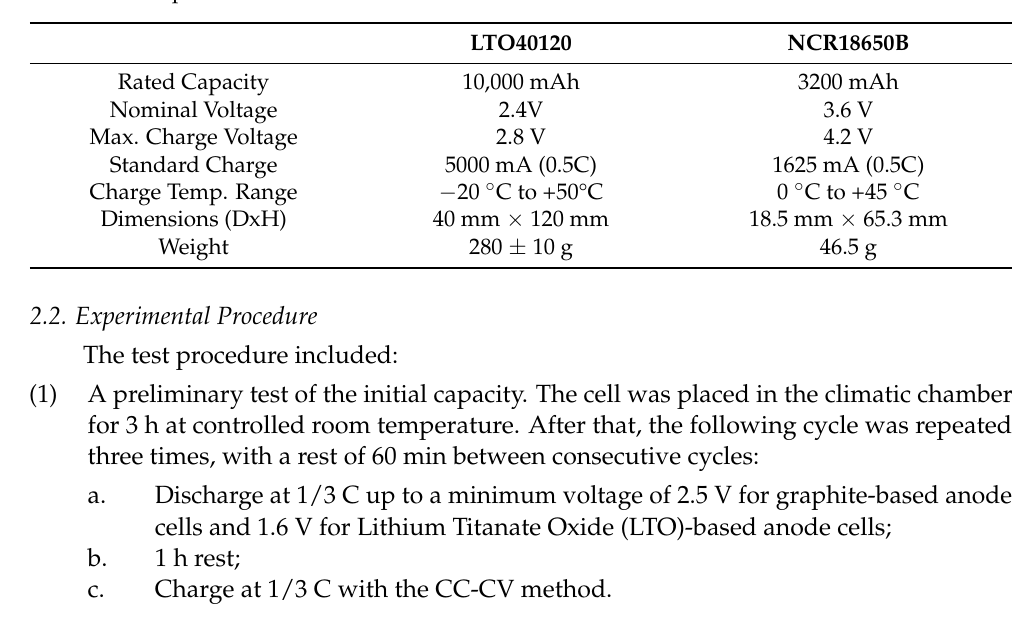
Table 1. Main parameters of the tested